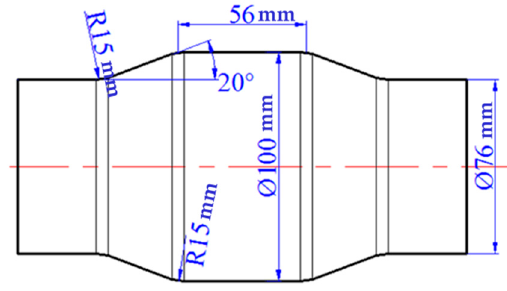
Figure 1. Shape and dimension of the sample.